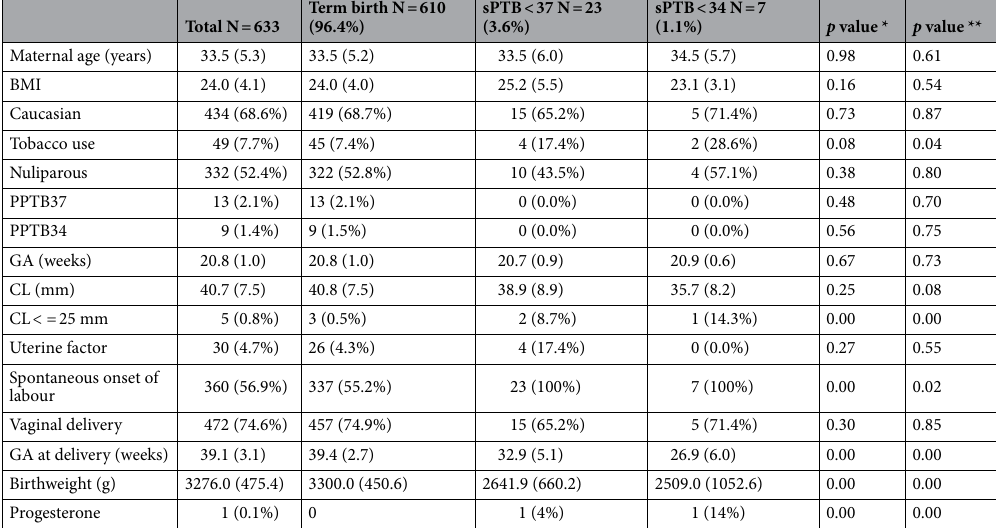
Table 1. General characteristics of the population. Data given as: mean (std) or n (%). BMI body mass index, GA gestational age, sPTB spontaneous preterm birth, CL cervical length, PPTB37 previous preterm birth at week 37, PPTB34 previous preterm birth at week 34. Uterine Factor Uterine conisation or malformation. p value, fisher exact test (discrete variables) or t-test (continuous variables) significance value between cases and controls. Progesterone, Patient received progesterone. *Comparison between term group and sPTB < 37 weeks. **Comparison between term group and sPTB < 34